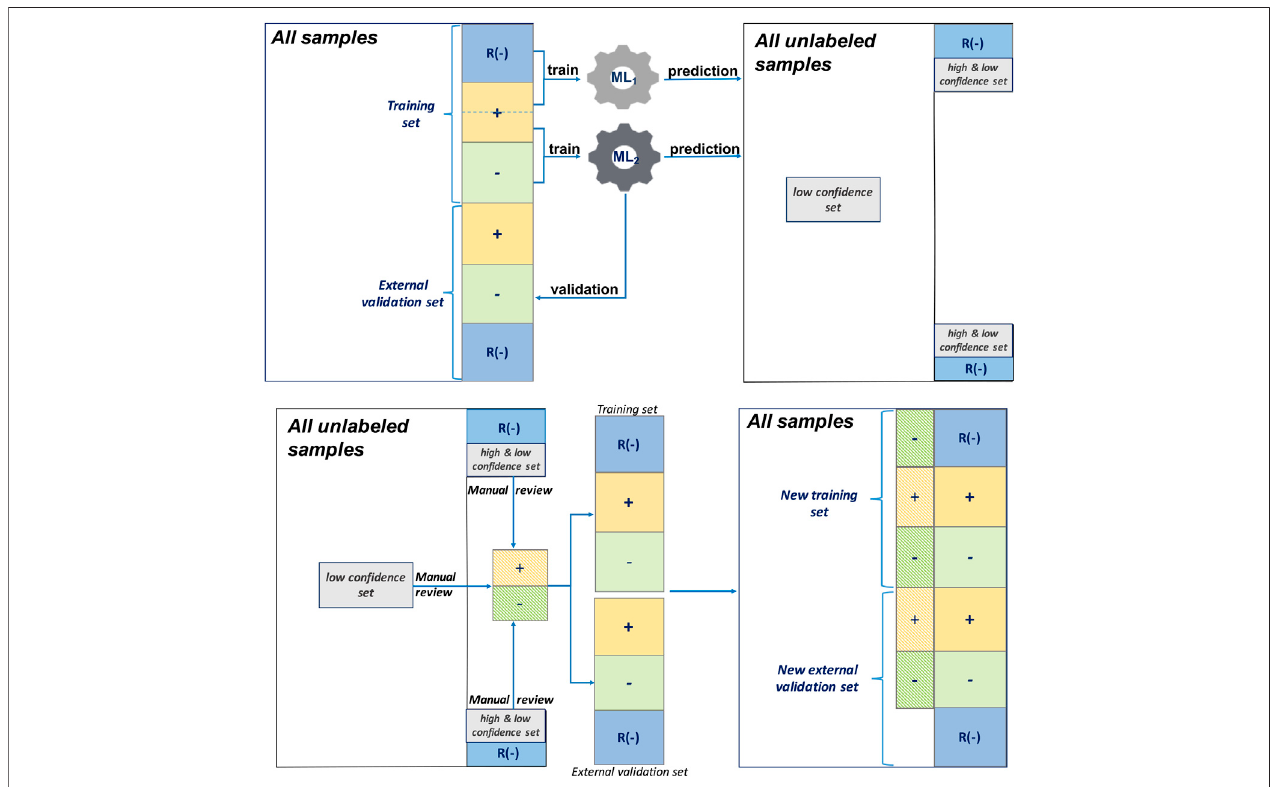
FIGURE 6 | Active learning work fl ow with two separate ML algorithms, uncertainty sampling plus random negative sampling, and validation sample update.